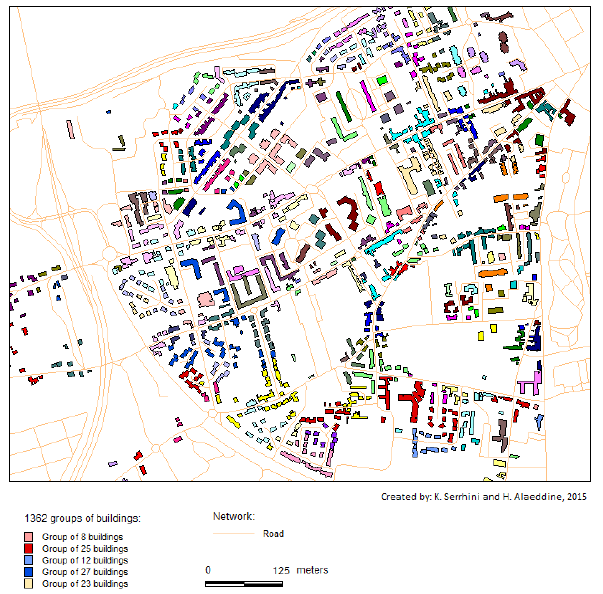
Figure 3. Assignment of buildings to nearest network nodes.